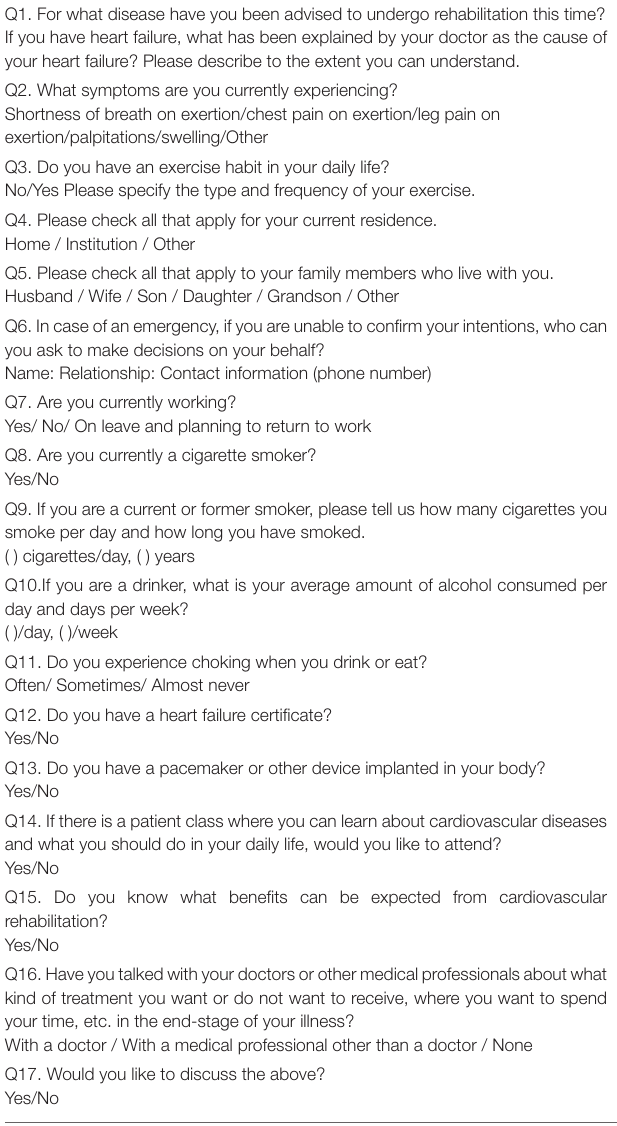
TABLE 1 | Questionnaire at the time of initiation of cardiac rehabilitation. Q1. For what disease have you been advised to undergo rehabilitation this time? If you have heart failure, what has been explained by your doctor as the cause of your heart failure? Please describe to the extent you can